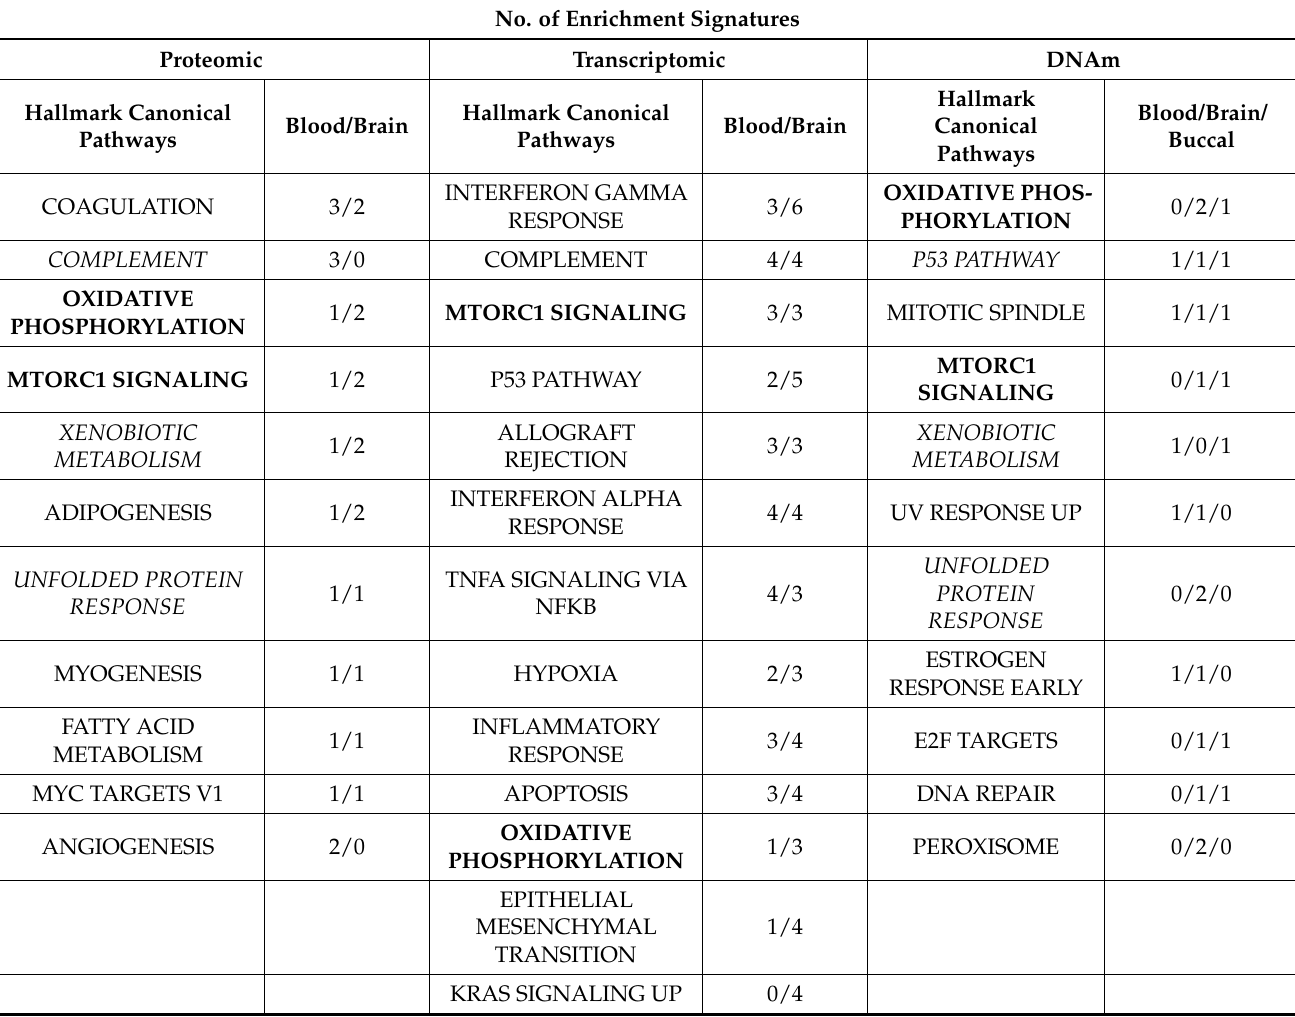
Table 2. A summary of the Hallmark Enrichment Signatures of 19 ASD molecular datasets, highlighting canonical pathways that were most consistently implicated in ASD proteomic, transcriptomic, and DNAm datasets from blood and brain tissue. Each independent dataset was annotated with respect to the top ten significantly enriched Hallmark canonical pathways (FDR < 0.5); data indicate the number of enrichment signatures implicating each canonical pathway. Pathways in bold = strongly supported using all three molecular approaches; pathways in italicised = supported by two (of three) molecular